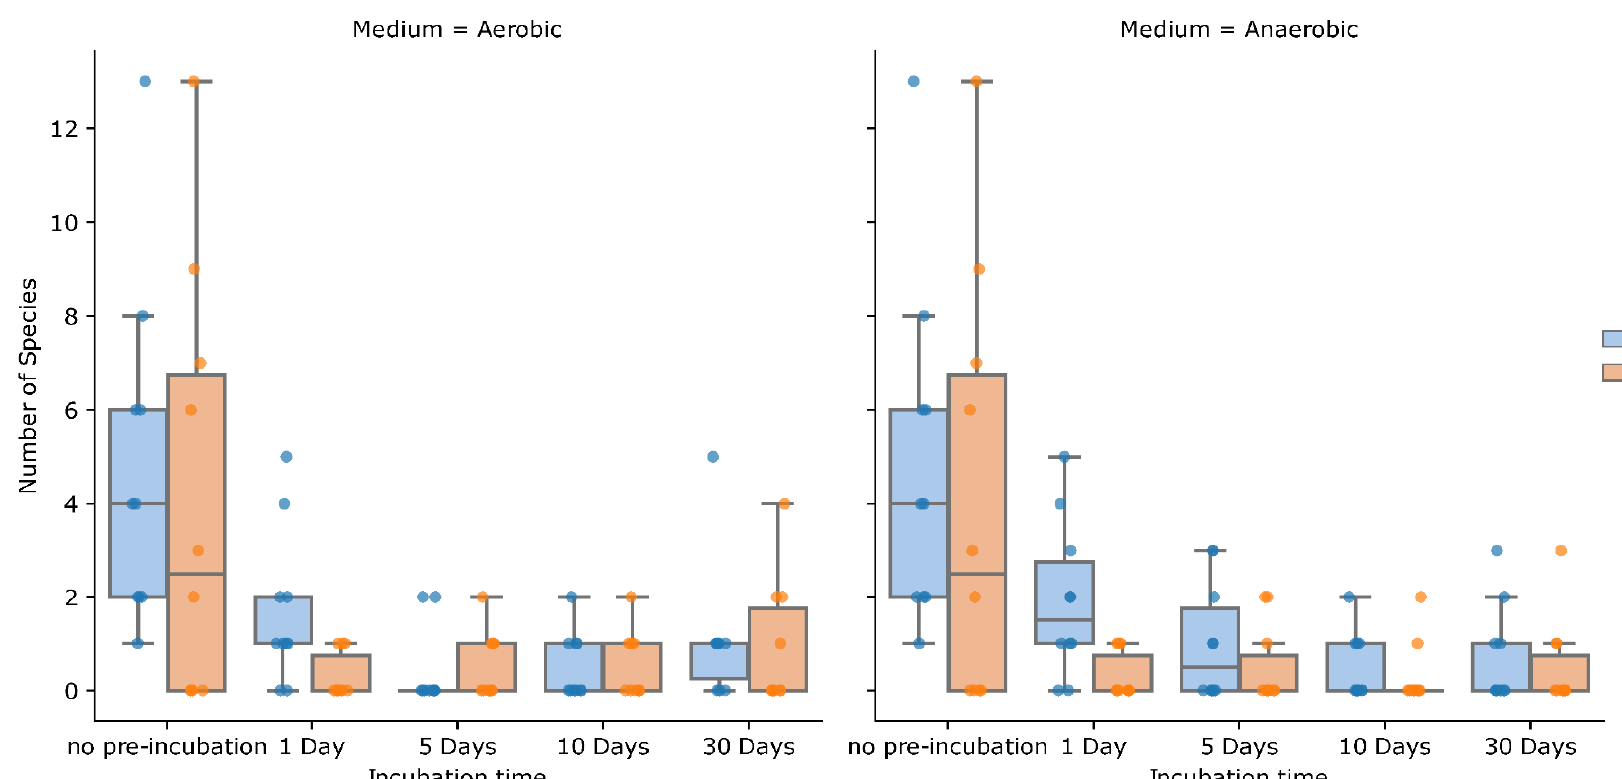
Figure 5. Scattered boxplot of the number of facultative (blue) and obligate (orange) anaerobic species at different incubation times.